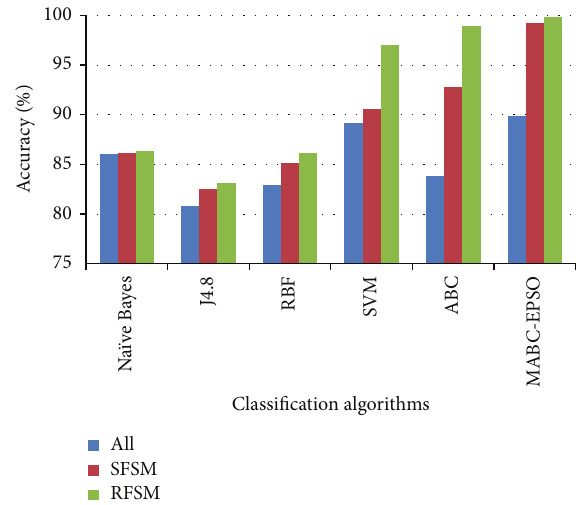
Figure 5: Accuracy comparison of classifiers for R2L dataset.